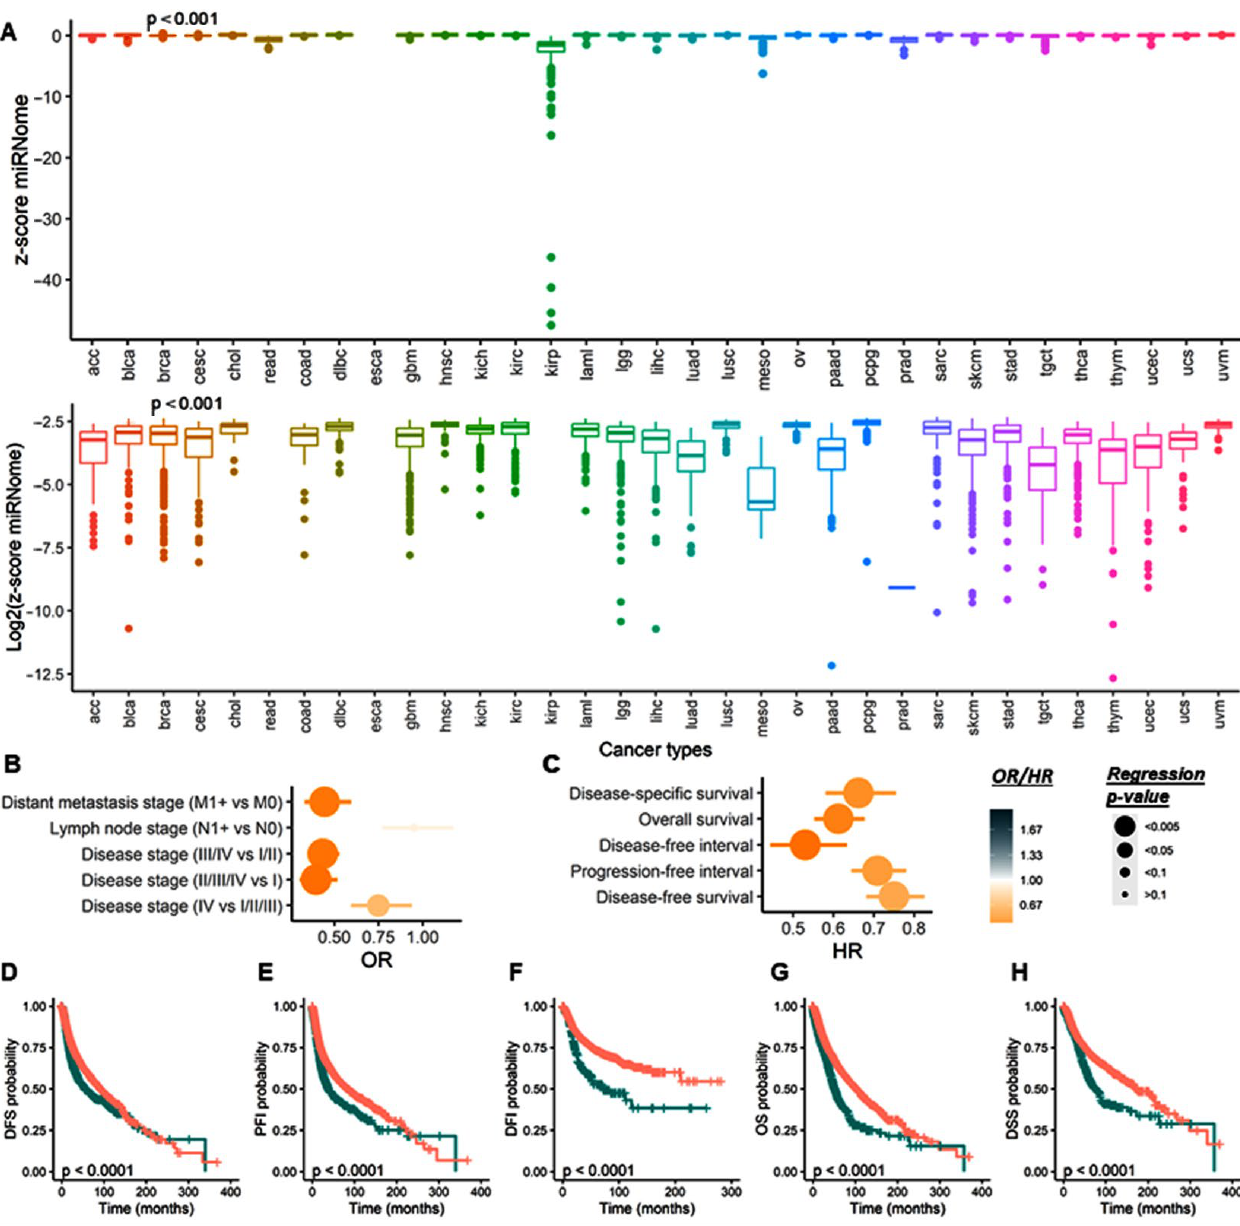
Figure 13. The total miRNome score is an independent marker for late stages and worse outcomes in cancer. ( A ) Box plots representing the distribution of the z-score miRNome across the samples without further transformation (top) and log2 transformation (bottom). ( B , C ) Logistic and Cox re- gression analysis to predict the impact of the z-score total miRNome on clinical ( B ) and survival ( C ) parameters. Significant p -value < 0.05. ( D – H ) Kaplan–Meier curve estimated for the z-score total miRNome according to DFS ( D ), PFI ( E ), DFI ( F ), OS ( G ), and DSS ( H ). Log-rank test p -value. Sig- nificant p -value < 0.05. DFI, Disease-free interval; DFS, Disease-free survival; DSS, Disease-specific survival; OS, Overall survival; PFI, Progression-free interval. After adjusting for age, gender, and race, the total miRNome score was defined as an independent marker for the prediction of disease stage (III/IV vs. I/II, OR = 0.28, OR-CI 95% = 0.18–0.32, p = 2.20 × 10 −1 6 ; II/III/IV vs. I, OR = 0.26, 95% CI = 0.17–0.38, p = 5.86 × 10 −1 2 ; IV vs. I/II/III, OR = 0.73, 95% CI = 0.54–0.98, p = 0.038), recurrence (DFS, HR = 0.70, 95% CI = 0.63-0.77, p = 3.58 × 10 −1 2 ; PFI, HR = 0.66, 95% CI = 0.60–0.74, p = 5.48 × 10 −1 5 ; DFI, HR =